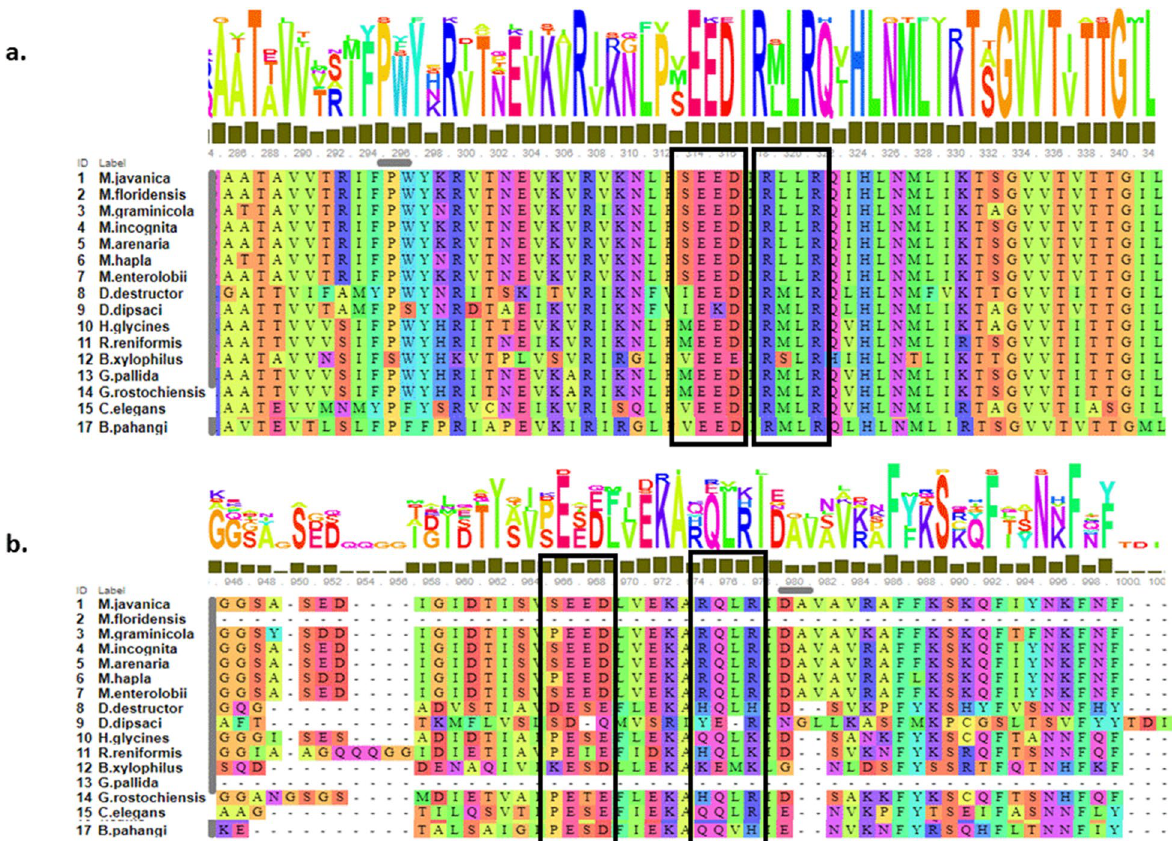
Figure 8. Occurrence of host-translocation RxLR-like motif in MCM2 proteins of 16 species of nematodes. ( a , b ) Alignment of all seven Meloidogyne spp. shown in Fig. 7 with cyst nematodes Globodera pallida (GPLIN_000686900), Globodera rostochiensis (GROS_g09797.t1), Heterodera glycines (Hetgly.G000003842); migratory endoparasites Bursaphelenchus xylophilus (BXY_0765600), Ditylenchus destructor (Dd_02935), Ditylenchus dipsaci (jg5302); semi-endoparasitic nematode Rotylenchus reniformis (TRINITY_GG_28486_ c36_g1_i1); free-living, bacterial feeder nematode Caenorhabditis elegans (BX284602.5), and animal nematode Brugia pahangi (Bm6301b.1). ( a ) First RxLR1-like following the SEED motif region (in black rectangle) and ( b ) second RxLR-like motif following the SEED motif region (in black